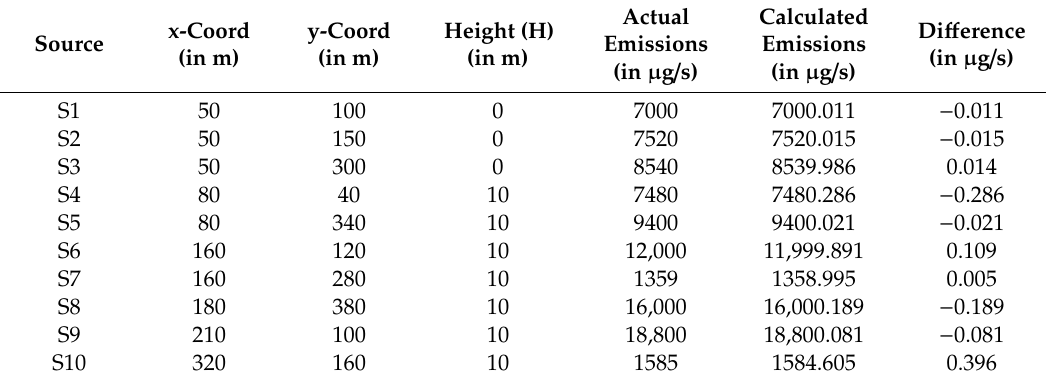
Table 3. Comparison of assumed and calculated emission rates in Step